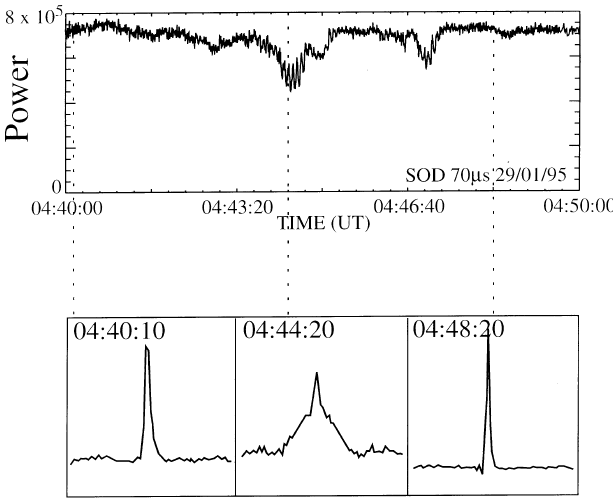
Fig. 9. An interesting example of data where the returned power reveals structure and periodicity during decreases in the received power. At selected times, the corresponding COSC spectrum is also